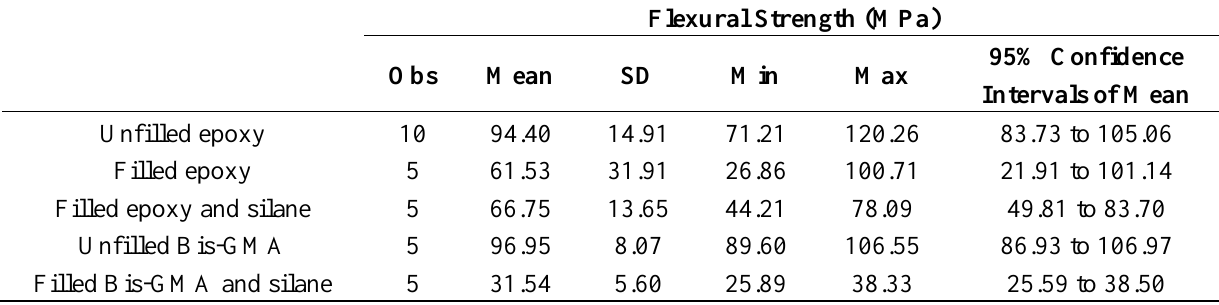
Table 4. Data summary of flexural strength (MPa) for the epoxy resin and Bis-GMA unfilled and filled samples.